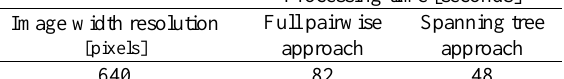
Figure 11. The guided matching estimation, multi windows matching and the results after the outliers